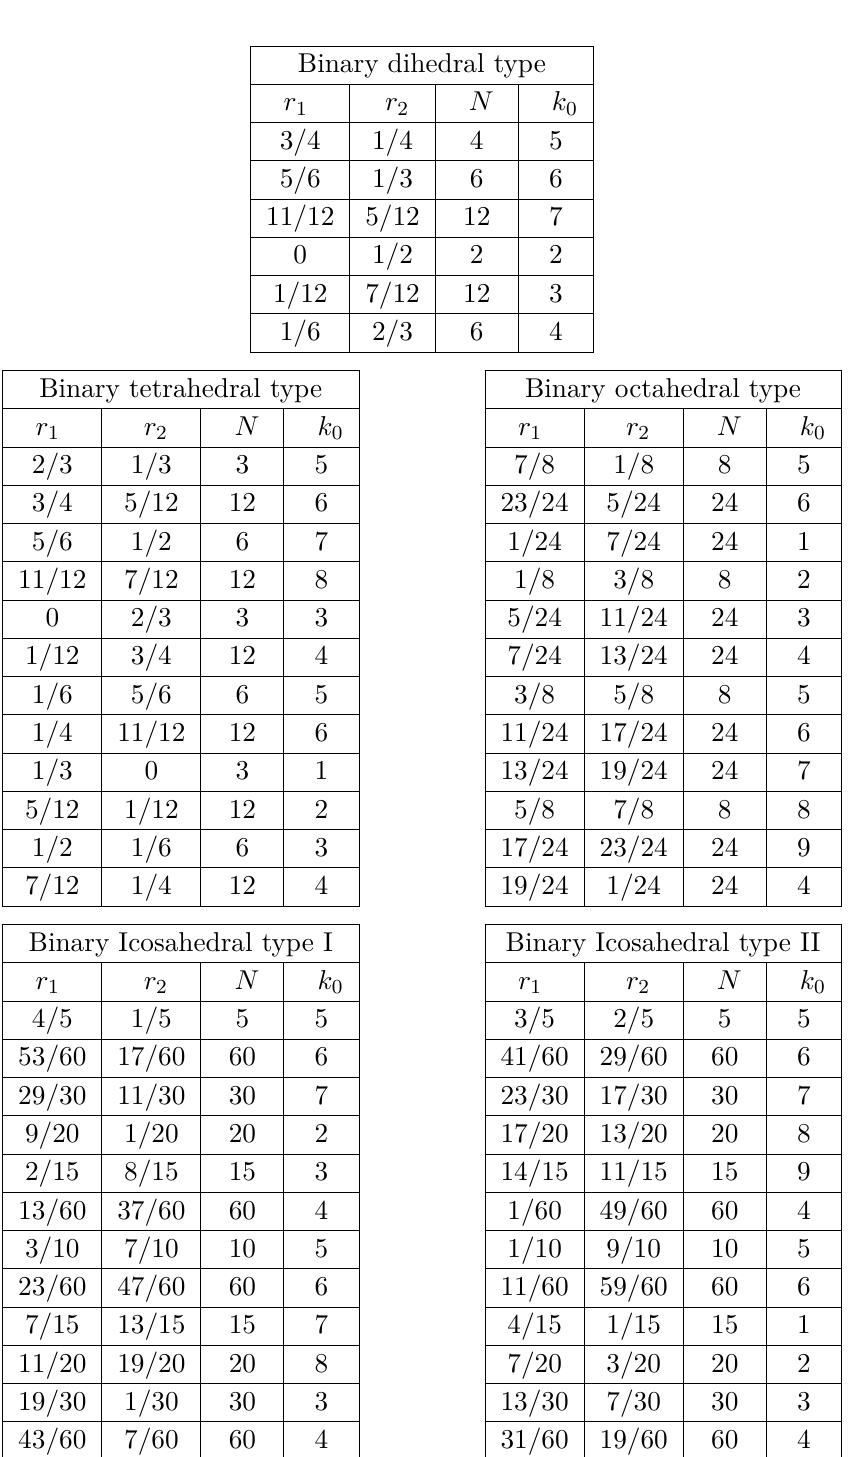
Table 3 . Summary of the 54 irreducible 2-d representations of SL(2 , Z ) with finite image, where N denotes the order of ρ ( T ) and k 0 = 6( r 1 + r 2 ) − 1 is the minimal modular weight. The unordered pair ( r 1 , r 2 ) uniquely determines the 2-d irreps up to a similar transformation, and the representation matrices ρ ( S ) and ρ ( T ) are given in eqs. (3.13),